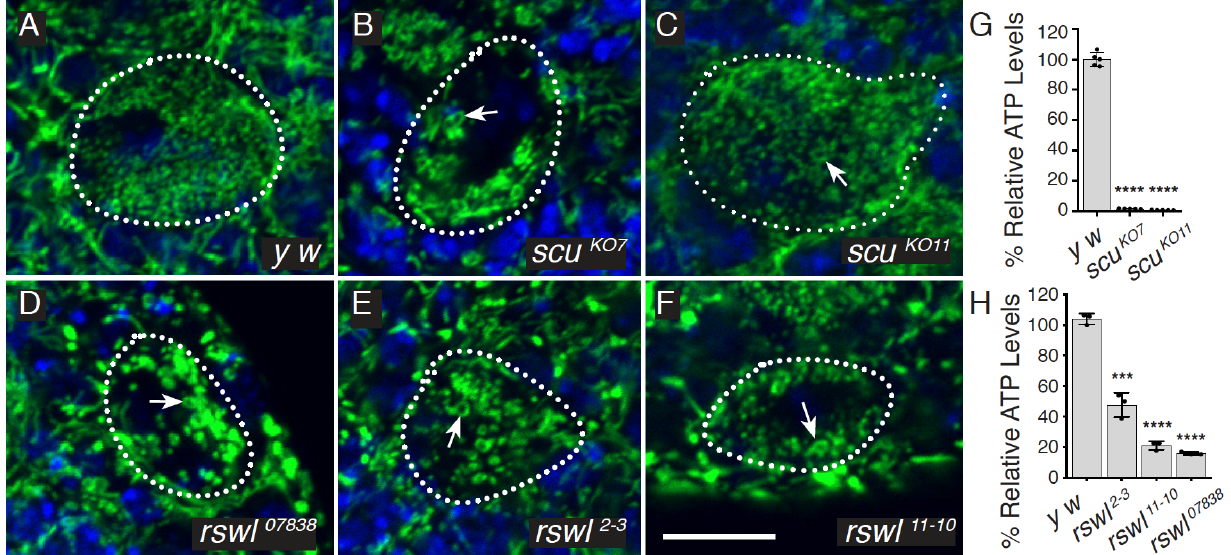
Figure 2. Loss of function of rswl and scu are associated with mitochondrial defects. ( A – F ) Neuroblast (NB) stem cells (dotted outlines) from larval brains labeled for mitochondria (green) and DAPI (blue). Neuroblasts in wild-type ( y w ) brains had small, dispersed mitochondria ( A ). In contrast, mitochondria in the neuroblasts of rswl and scu mutants ( B – F ) were swollen and ring-shaped (arrows). Number of NB with swollen mitochondria = 1/56 ( A ), 71/80 ( B ), 29/30 ( C ), 19/19 ( D ), 15/17 ( E ), and 22/25 ( F ). ( G , H ) Total relative ATP levels were reduced in scu ( G ) and rswl ( H ) mutant larvae. Green: anti-ATP synthase; blue: DAPI. Scale bar: 10 mm in F for A–F. Error bars: S.E.M. calculated using GraphPad PRISM using an unpaired t -test, two-tailed. ( G , H ). **** p < 0.0001; *** p < 0.001.